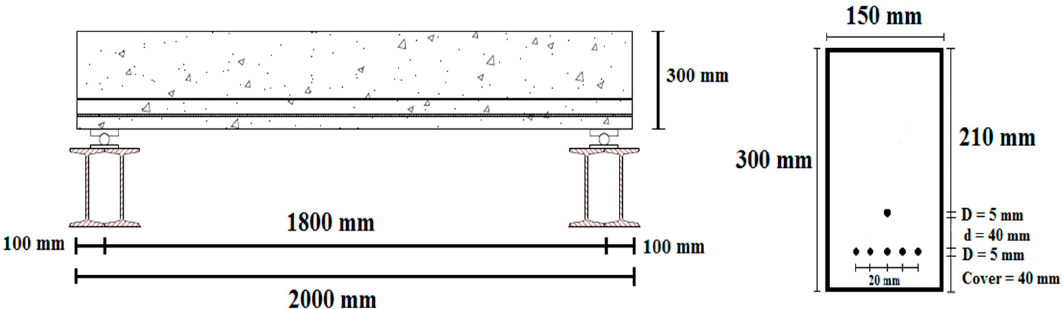
Figure 1. Beam dimensions and cross-section details.